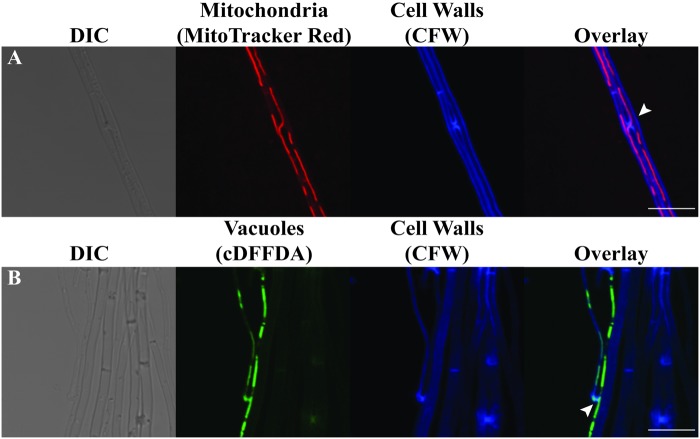
Vegetative hyphal fusion of E. festucae E2368 grown in culture establishing cytoplasmic continuity.Confocal micrographs showing DIC optics, mitochondria (A) or vacuoles (B), CFW staining, and overlaid images. Arrowheads indicate fusion bridges through which organelles extend into a neighboring compartment. Bars represent 10 μm.